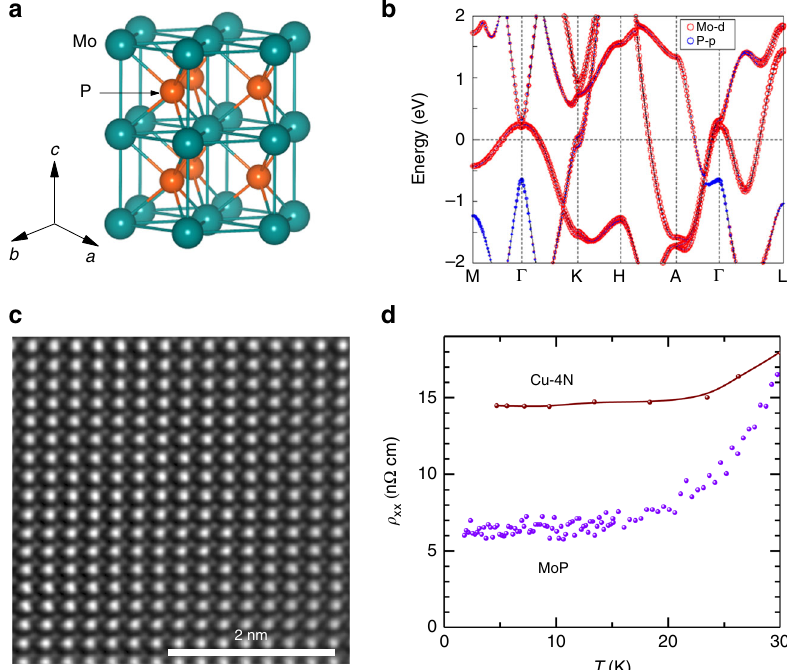
Fig. 1 Crystal structure, electronic band structure, high-resolution scanning transmission electron microscopic (HR-STEM) image and resistivity of MoP. a Schematic of the hexagonal crystal structure of MoP in which the Mo and P atoms are shown as green and orange spheres, respectively. b Energy dispersed band structure along the high symmetry directions, including spin-orbit coupling (SOC). Mo d -orbitals contributions (red) dominate at E F . c HR- STEM image along [110], showing Mo (bright large-dots) and P (small-dots). d Temperature dependent resistivity, ρ xx , of MoP compared with 99.99% (4 N) pure Cu